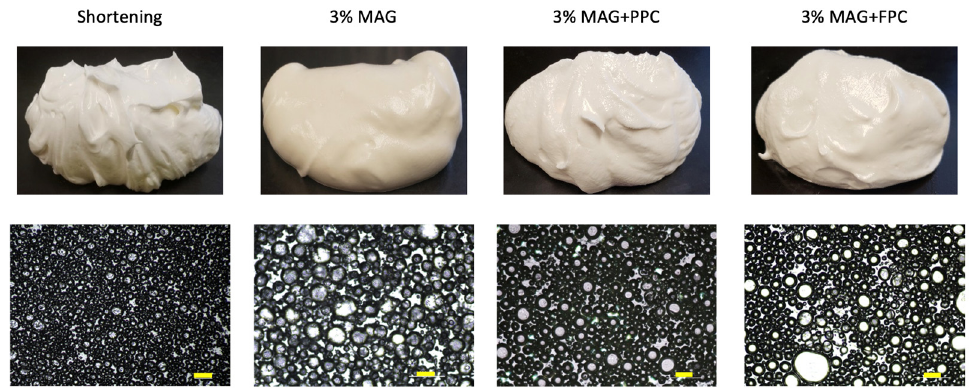
Figure 3. Visual observation and microstructure of different oleofoams prepared by whipping shortening and various MAG-based and MAG plus protein foam-templated oleogels. The scale bar indicates 100 mm. MAG, monoacylglycerols; PPC, pea protein concentrate-stabilized foam; FPC, faba bean protein concentrate-stabilized foam.